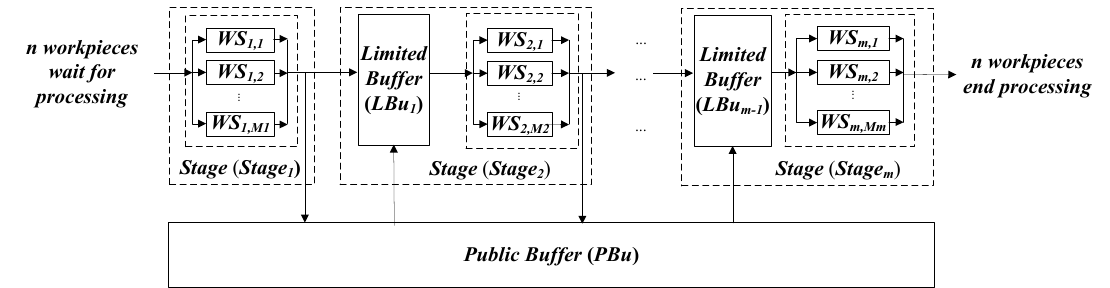
Figure 1. Mathematical model of flexible flow shop with limited buffer and public buffer.